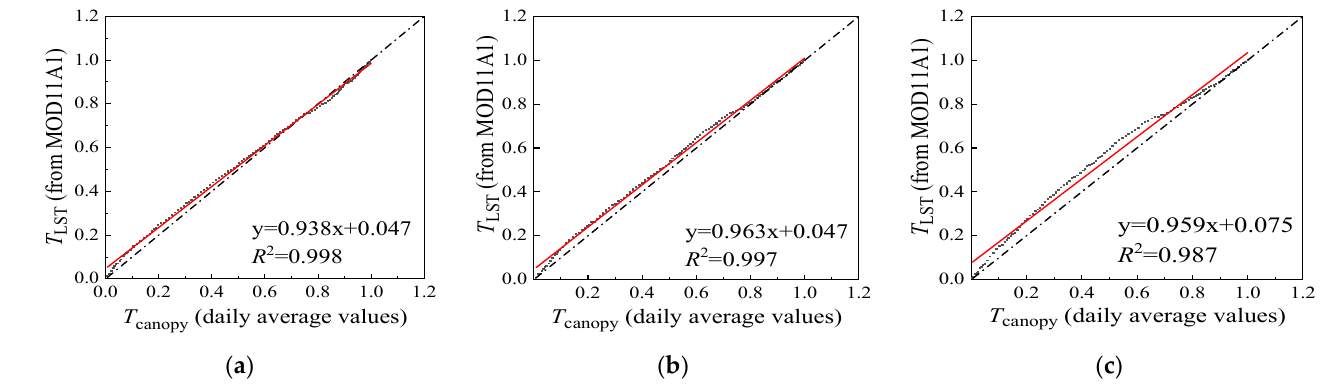
Figure 6. Regressions between the T LST calculated by the remote sensing instantaneous values at 11:30 a.m. (interpolation results) and daily average values ( T canopy ) observed from the CTMS system in 2017 (sample number = 116, with supplemented data). ( a ) H1; ( b ) H2; ( c ) H3. To verify its accuracy in spatial scale, the LSTs from MOD11A1 over two days (coupled